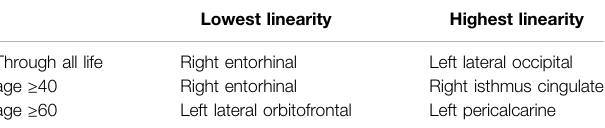
TABLE 5 | Linearity of the cortical thickness through